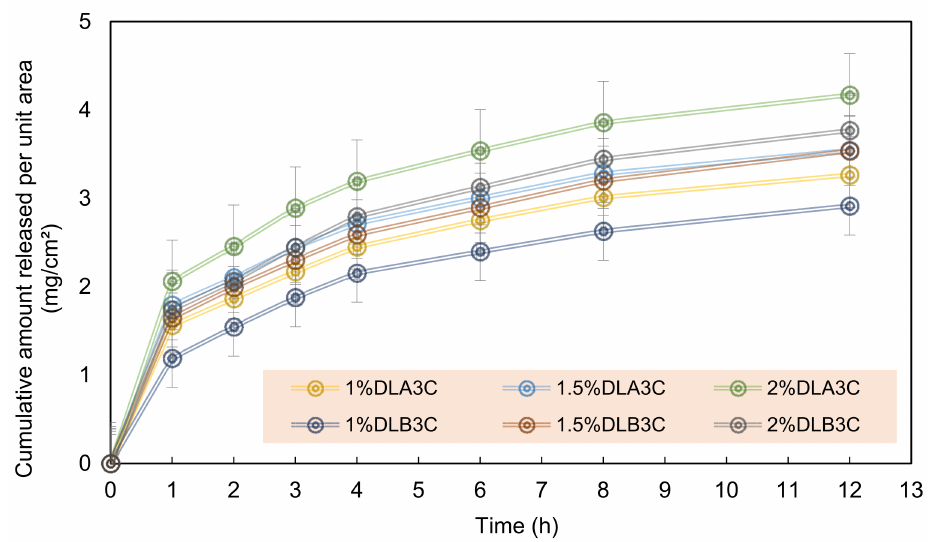
Figure 8. Cumulative amount of DS release per unit area (mg/cm 2 ) for DS-medicated DL A 3C and DL B 3C. Each data point represents mean ± SD of three